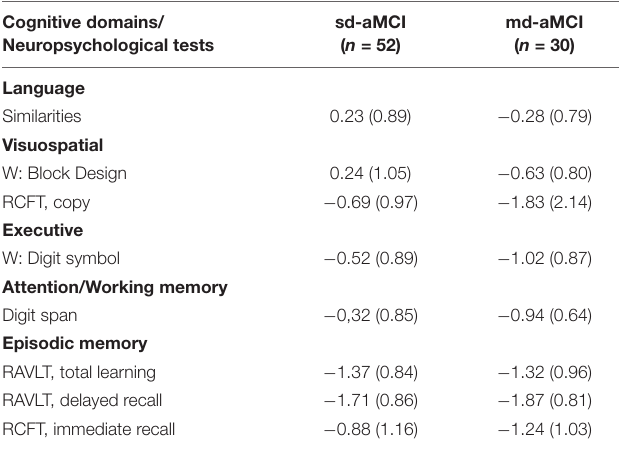
TABLE 3 | Neuropsychological test results in z -scores for subtyping of MCI patients into sd-aMCI and md-aMCI groups. Cognitive domains/ Neuropsychological tests